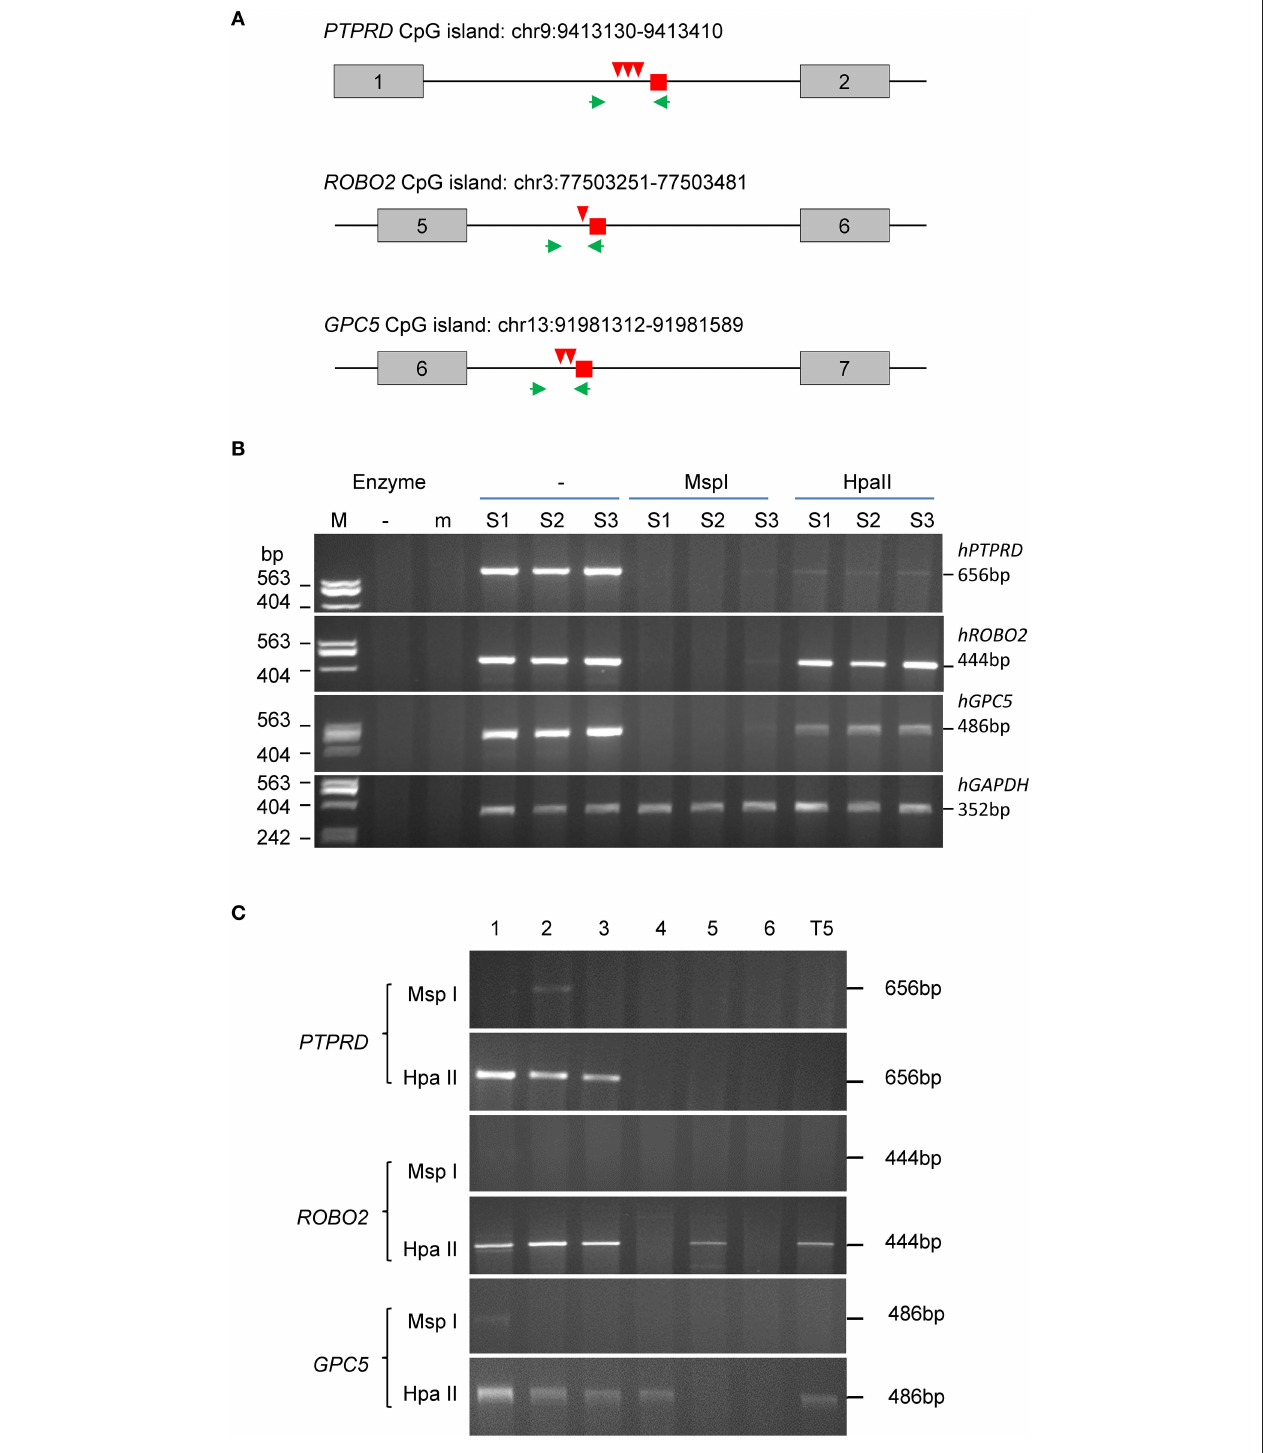
FIGURE 3 | MSRE-PCR validation of methylated CpG DNA of human (tumor) origin. (A) Diagram of the reads location (small square), restriction sites (arrowheads) and PCR primer locations (arrows) relative to the exon (boxes) and intron (lines) locations in PTPRD , ROBO2 and GPC5. Above each gene diagram is the chromosomal location of the CpG island covered by the PCR. (B) Agarose gels of PCR and MSRE-PCR products. The tumor DNA samples were digested using the methylation insensitive MspI or the sensitive HpaII prior to PCR using the gene-specific primers. The GAPDH primers are human-specific. (C) Agarose gels of methylation-sensitive MSRE-PCR products of the methylated markers ( PTPRD , ROBO2 and GPC5 ) from the gDNA of breast cancer tissues from node-negative patients. T5: lymphoblastoid cell line.